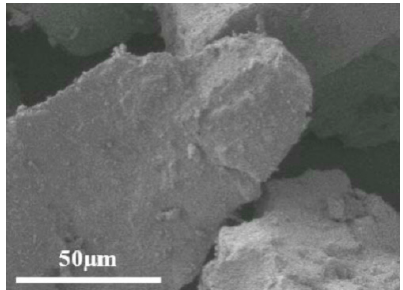
Figure 1. SEM graph of the OMC fine iron ore before reduction.